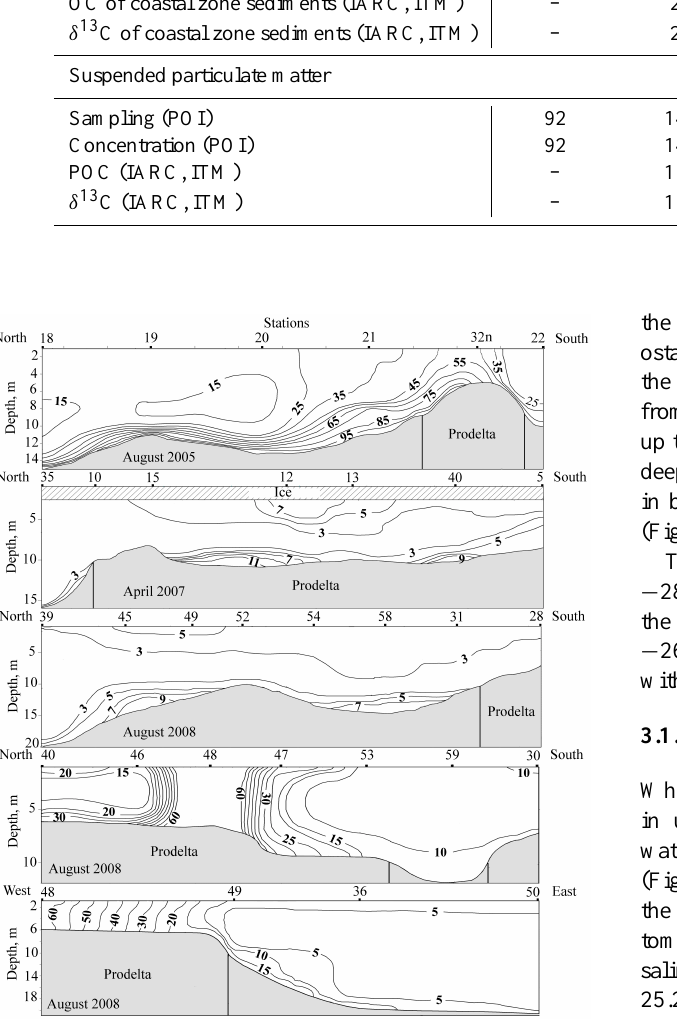
Fig. 4. Vertical sections of SPM (mgl − 1 ) distribution for years 2005, 2007 and